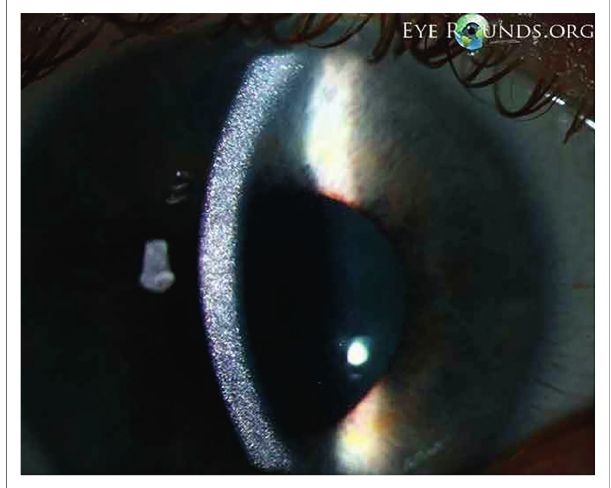
FIGURE 2: Corneal crystalline changes observed in